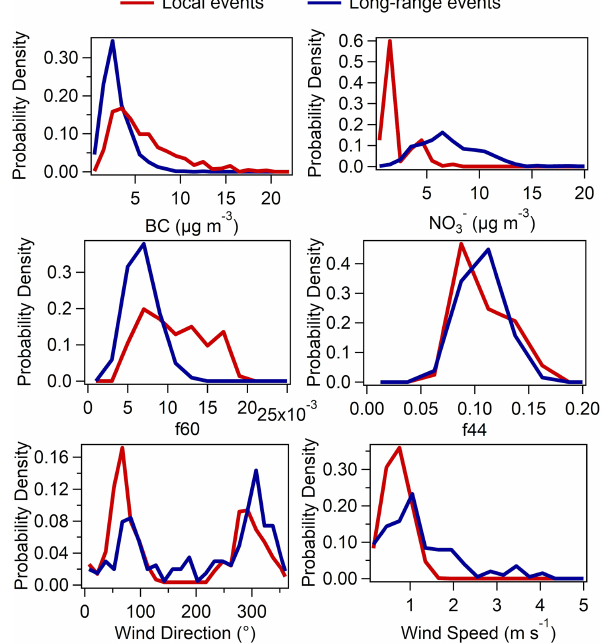
Figure 10. Probability density distributions of BC, NO − wind direction and speed during PM 2 . 5 exceedance days belonging to local (dark red) and long-range (dark blue) categories.